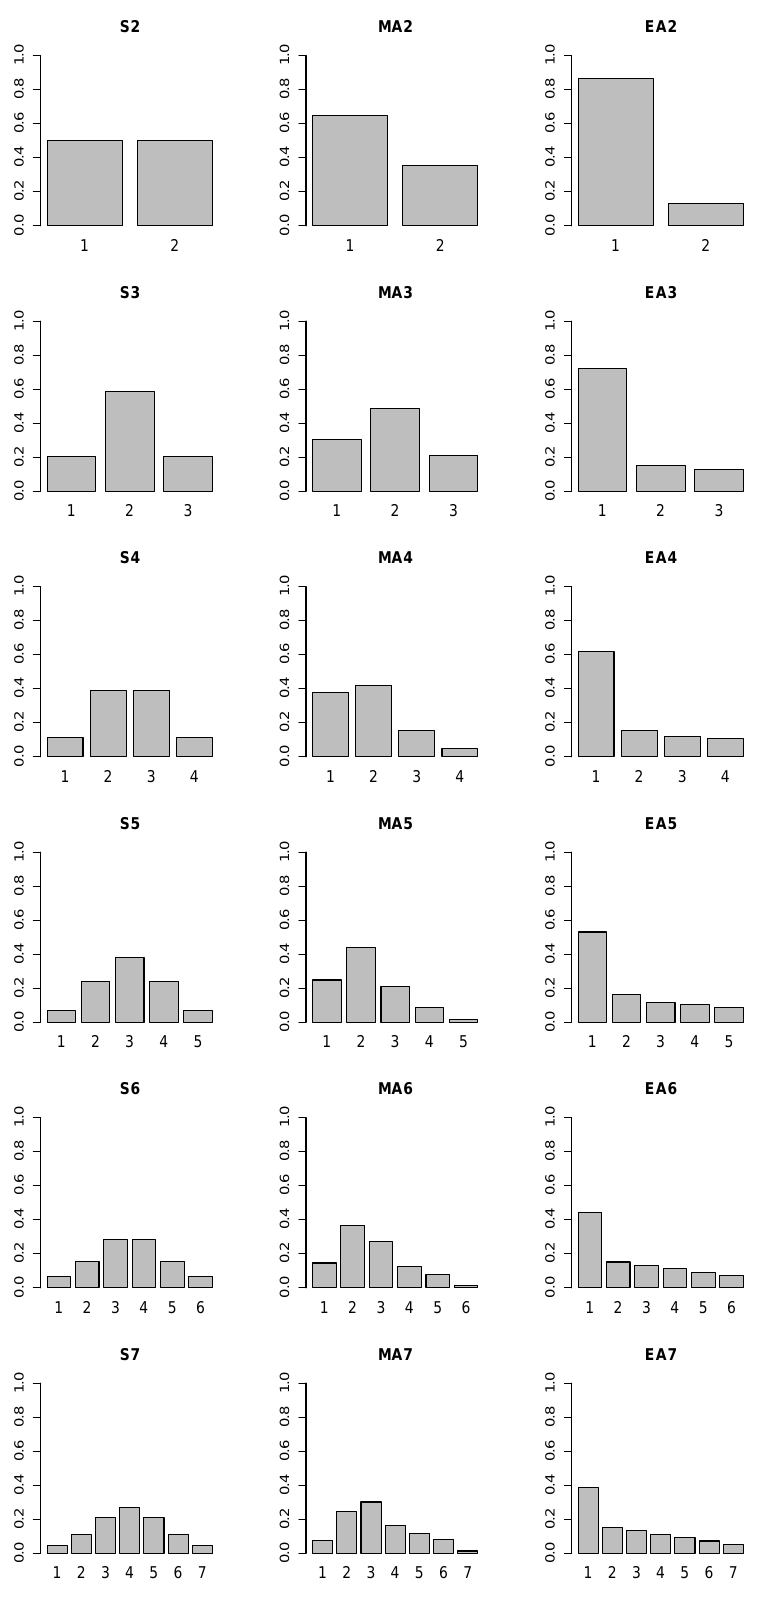
Figure 1. Distribution types used in simulation studies 1 and 2. S2, . . ., S7 = symmetric distribution with 2 to 7 categories; MA2, . . ., MA7 = moderate asymmetric distribution with 2 to 7 categories; EA2, . . ., EA7 = extreme asymmetric distribution with 2 to 7